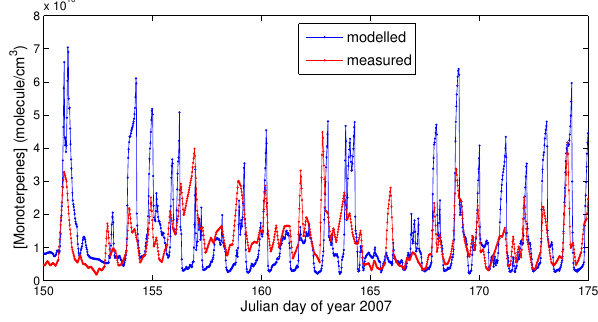
Figure 7. Modelled (MEGAN 2.04) and measured (at the SMEAR II station) monoterpene concentrations at 4m height in June